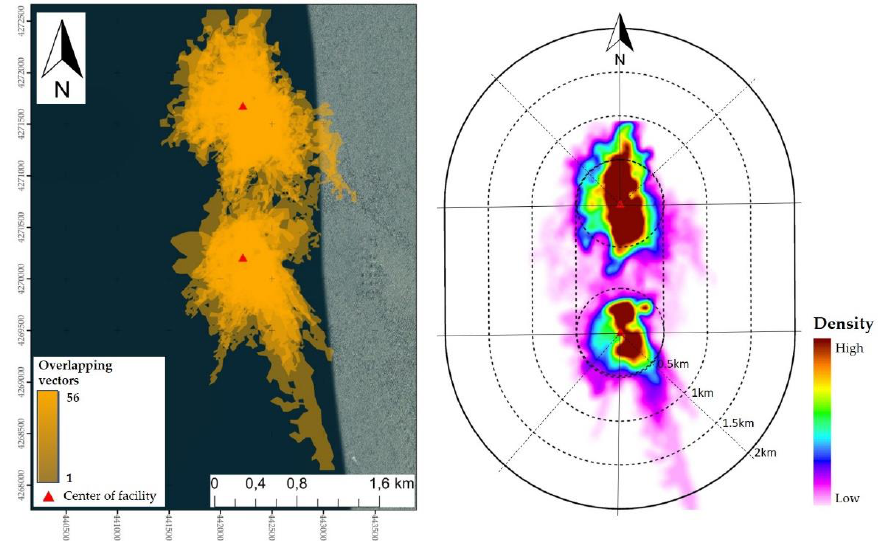
Figure 15. Biogenic oil films detected during the study period (2019–2020) in Karaburun Peninsula (Site 2). The overlapping vectors (left) were used to create the density map (right). Both images show the spatial extend of the film in the surrounding area.